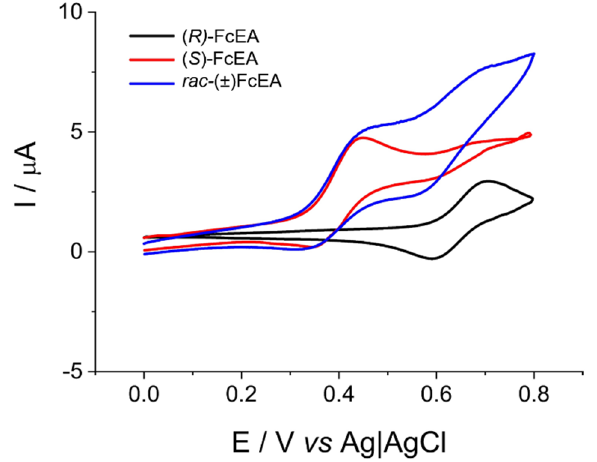
Figure 2. CVs recorded at an oligo-( S )-BT 2 T 4 - Au electrode in a CH 3 CN + 0.1 M TBAPF 6 solution containing 1 mM ( S )-FcEA, 2 mM rac -FcEA and 0.6 mM ( R )-FcEA (as indicated in the figure). Scan rate 0.05 V s − 1 .